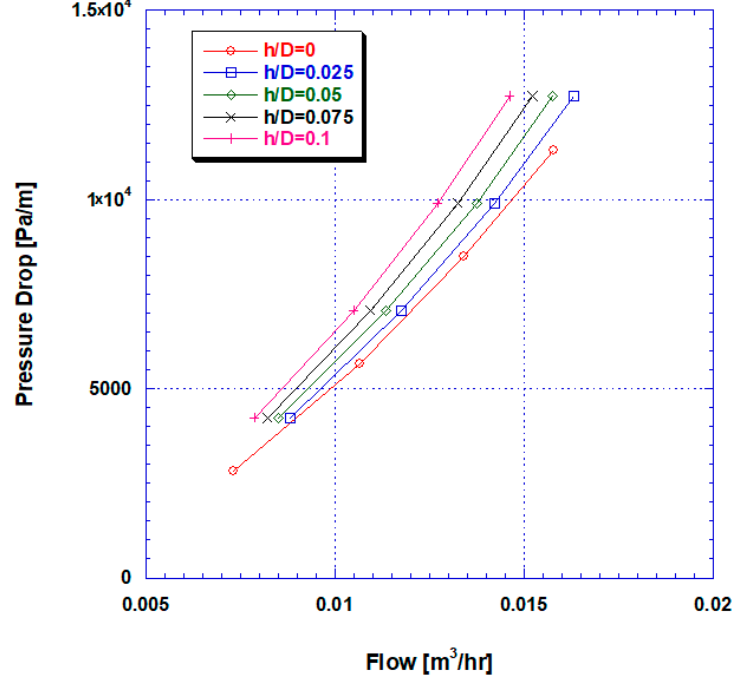
Figure 5. Computational results on the effect of the fouling-layer thickness h on pressure drop in the retentate channel. The flow rate corresponds to the computational domain (Figure 1), for the range of superficial velocities U of interest.